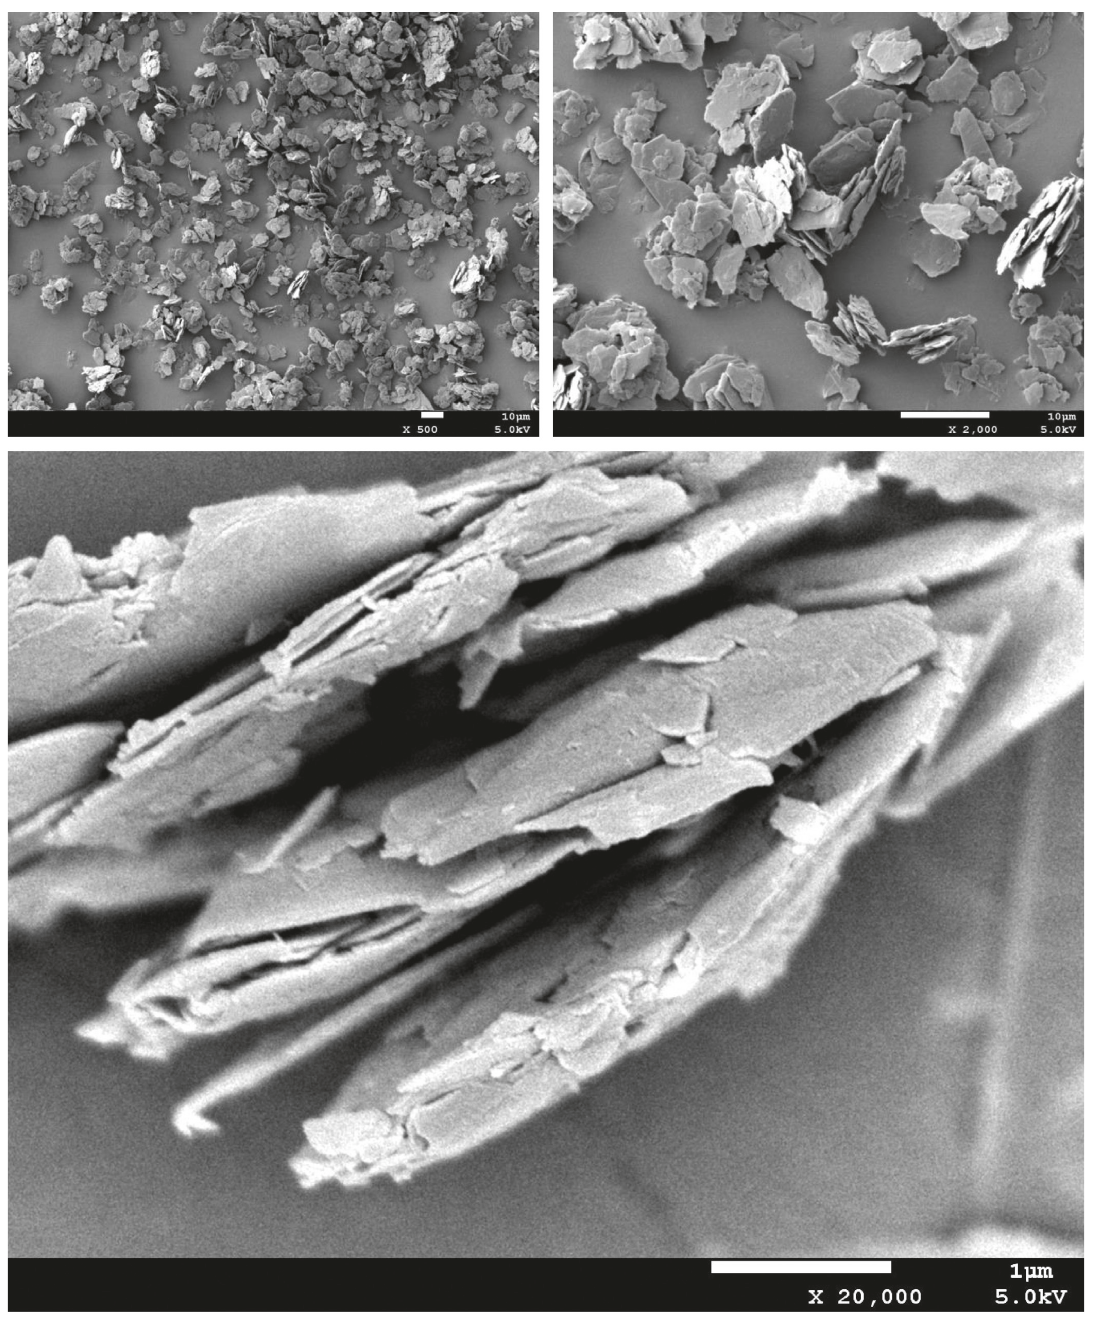
Figure 2: SEM analysis of ZRJ-S1 additive. Table 4: The effect of ZRJ-S1 on the performance of cement